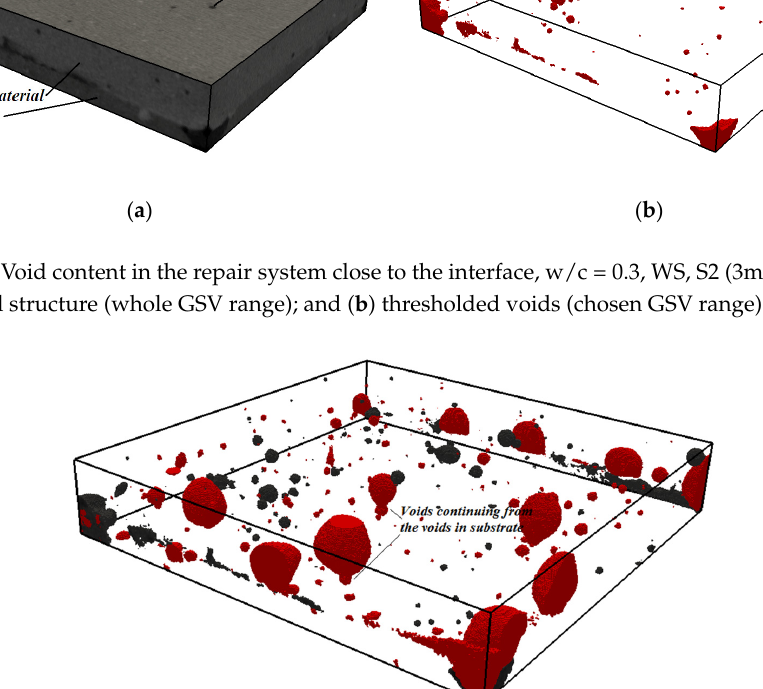
Figure 16. Void content in the repair system close to the interface w/c = 0.3, WS, S2 and w/c = 0.3, DS,